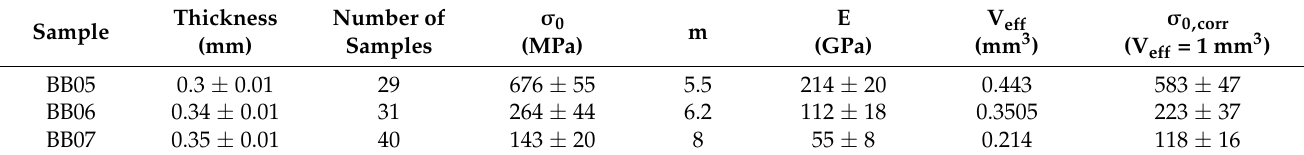
Table 2. Elastic and mechanical properties obtained by the ball-on ring tests of 3YSZ.